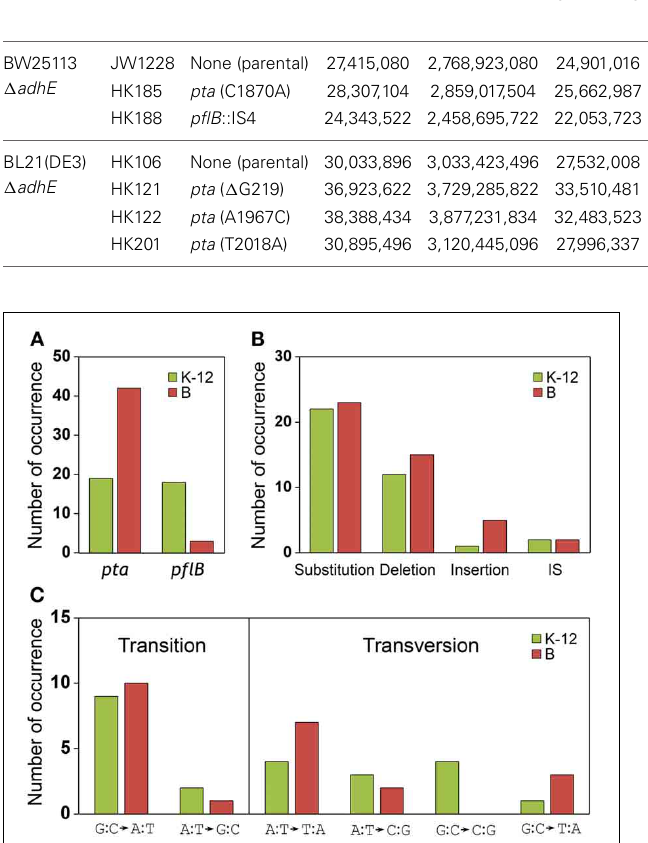
FIGURE 4 | Analysis of compensatory mutations for anaerobic adaptation in (cid:2) adhE mutants of K-12 and B strains. Thirty seven K-12 mutants (derived from BW25113 (cid:2) adhE ) and 45 B mutants [derived from BL21(DE3) (cid:2) adhE ] were analyzed by DNA sequencing. (A) Mutation occurrence in pta and pflB genes, (B) types of mutations, and (C) types of substitutions were compared in respect of K-12 and B strains.